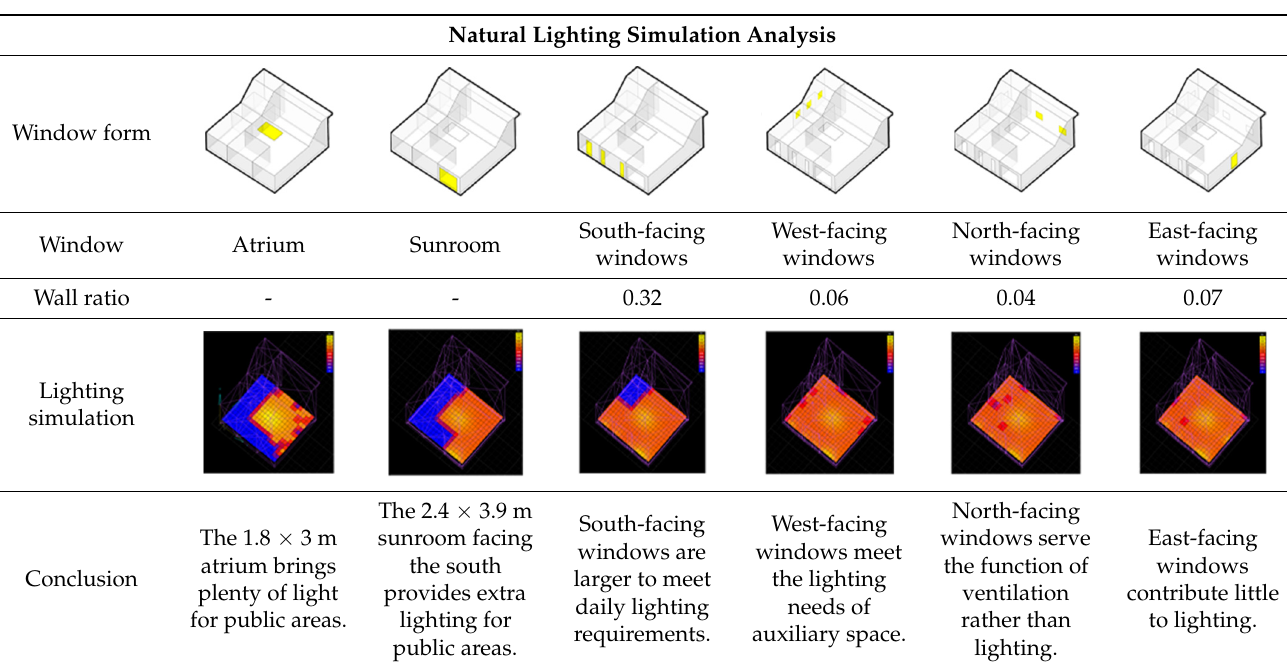
Table 3. Natural lighting simulation.